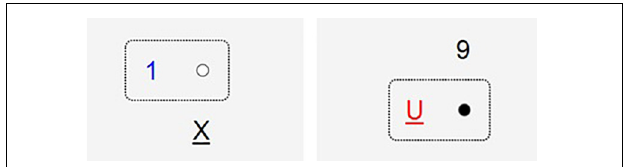
FIGURE 1 | Two examples of task stimuli of the primary WOTRKLAU